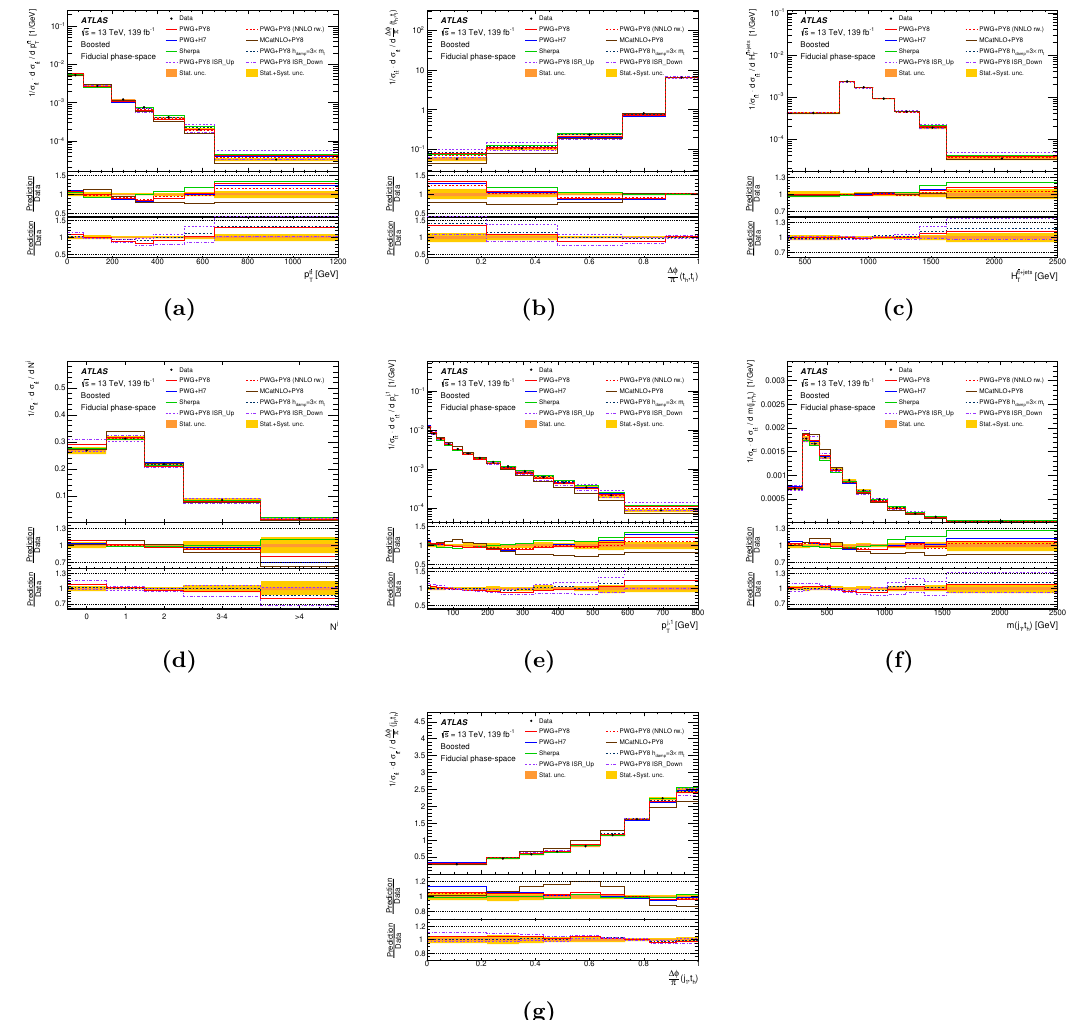
Figure 24. Normalised differential cross-section measurements for the observables related to jets produced in association with the t ¯ t system. The cross-section is shown as a function of (a) p t ¯ t , T (b) ∆ φ ( t ) , (c) H t ¯ t +jets , (d) N j , (e) p j, 1 , (f) m ( j ) and (g) ∆ φ ( j ) . In each plot the , t , t , t h ‘ 1 h 1 h T T data are compared with predictions from various MC generators. PWG+PY8 corresponds to the Powheg+Pythia sample, PWG+H7 to the Powheg+Herwig sample and MCatNLO+PY8 to the MadGraph5_aMC@NLO+Pythia sample. The orange band shows the size of the statistical uncertainty and the yellow band shows the size of the total uncertainty. The lower two panels in each subfigure display the ratios of the different predictions to the